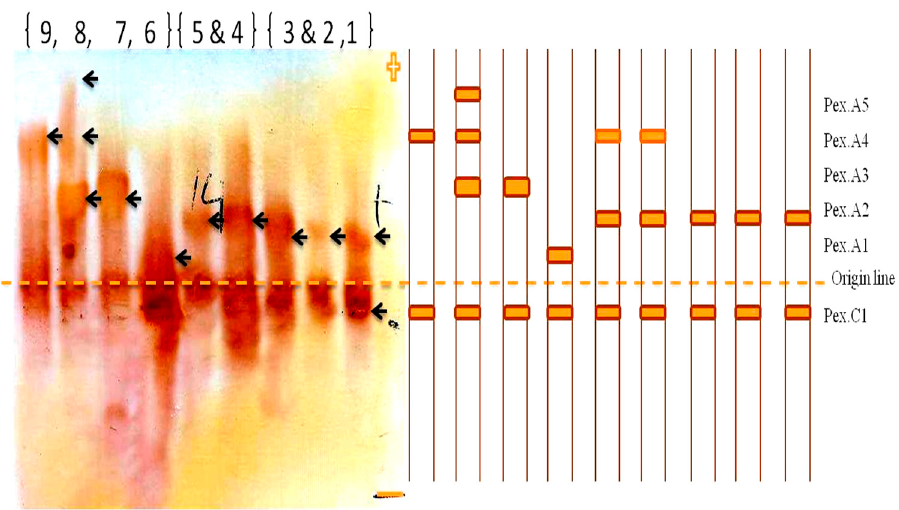
Figure 3. Zymograme of peroxidase isozyme of Acacia ssp. (1, 2 and 3) tortilis ssp. raddiana (Siwa), (4&5) tortilis ssp. raddiana (Borg El-Arab), (6) A. farnesiana , (7) A. stenophylla , (8) A. sclerosperma and (9) A. saligna .